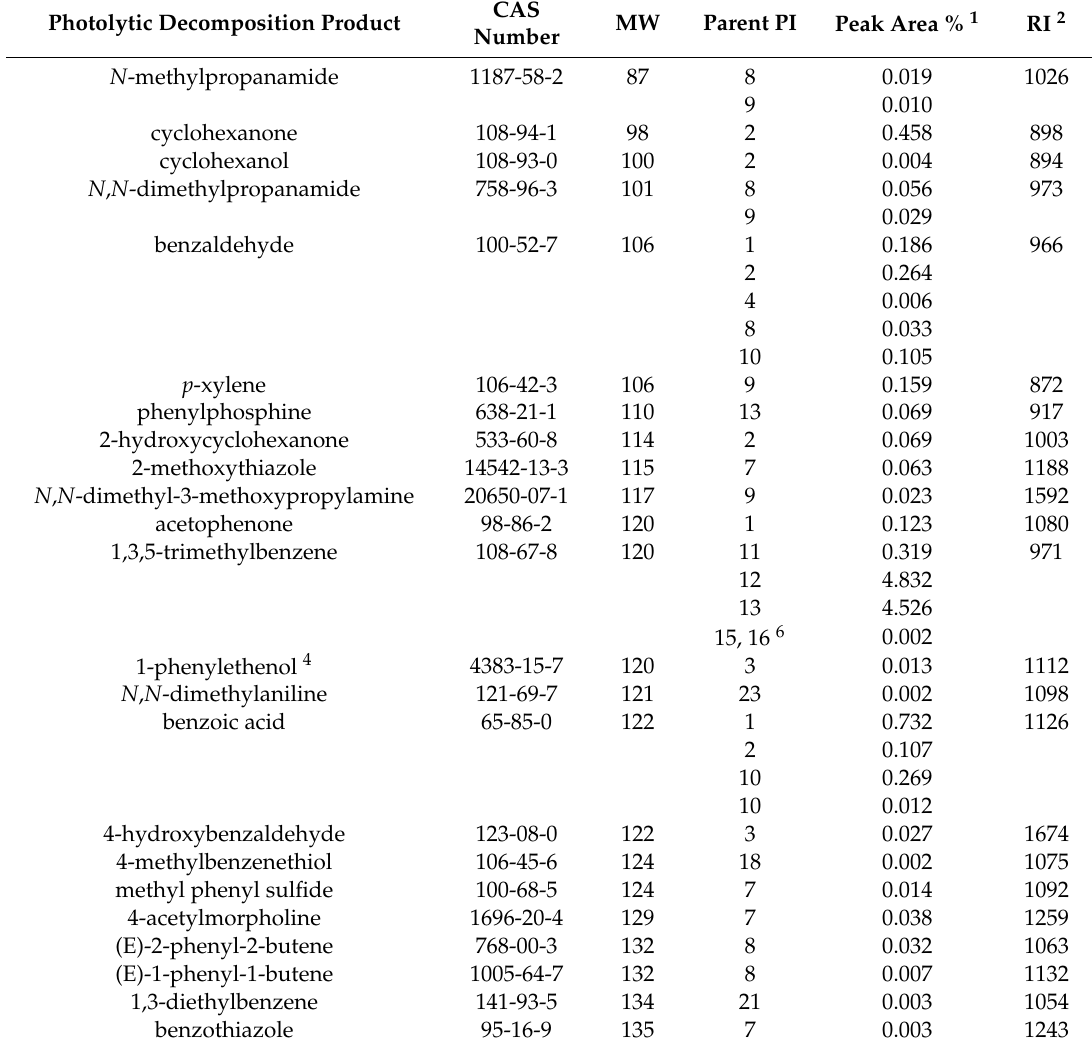
Table 2. Photolytic Decomposition Products Identified.